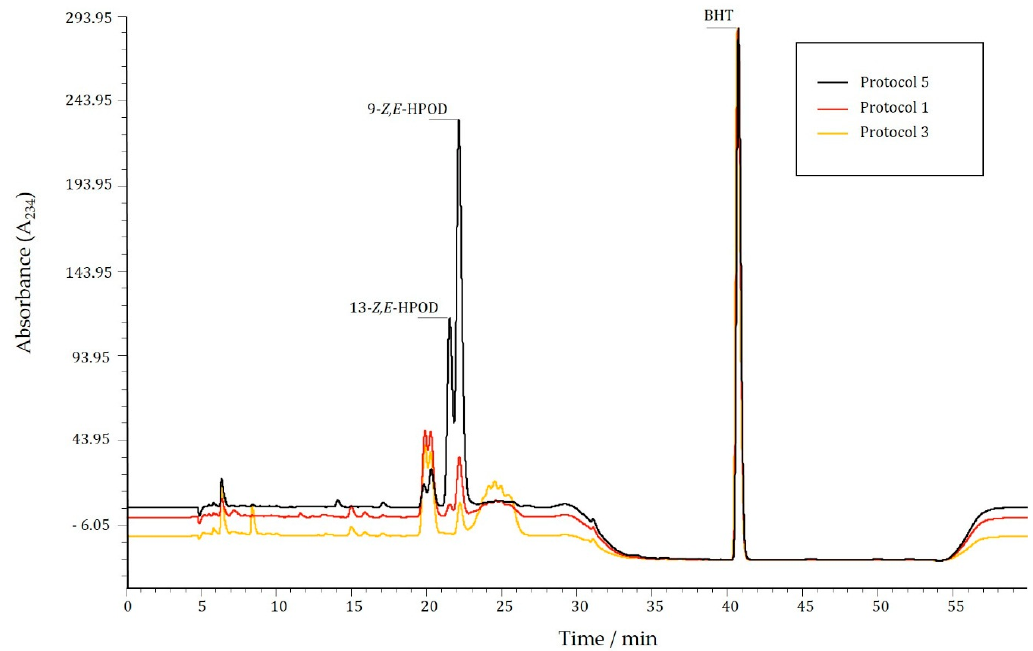
Figure 2. Overlaid representation of chromatograms of LOX product formation obtained by applying protocol 1, 3 and 5.